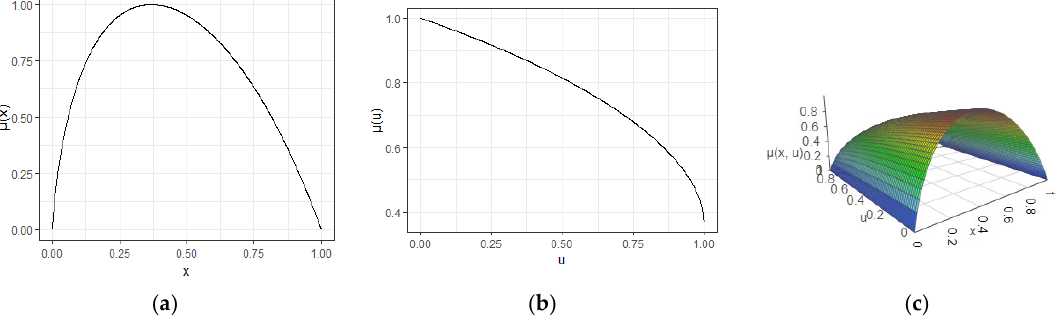
Figure 2. Membership functions. ( a ) Partial membership functions () . ( b ) Partial membership functions ( u ) . ( c ) Type 2 representation of µ ≈ ( x , u ) .